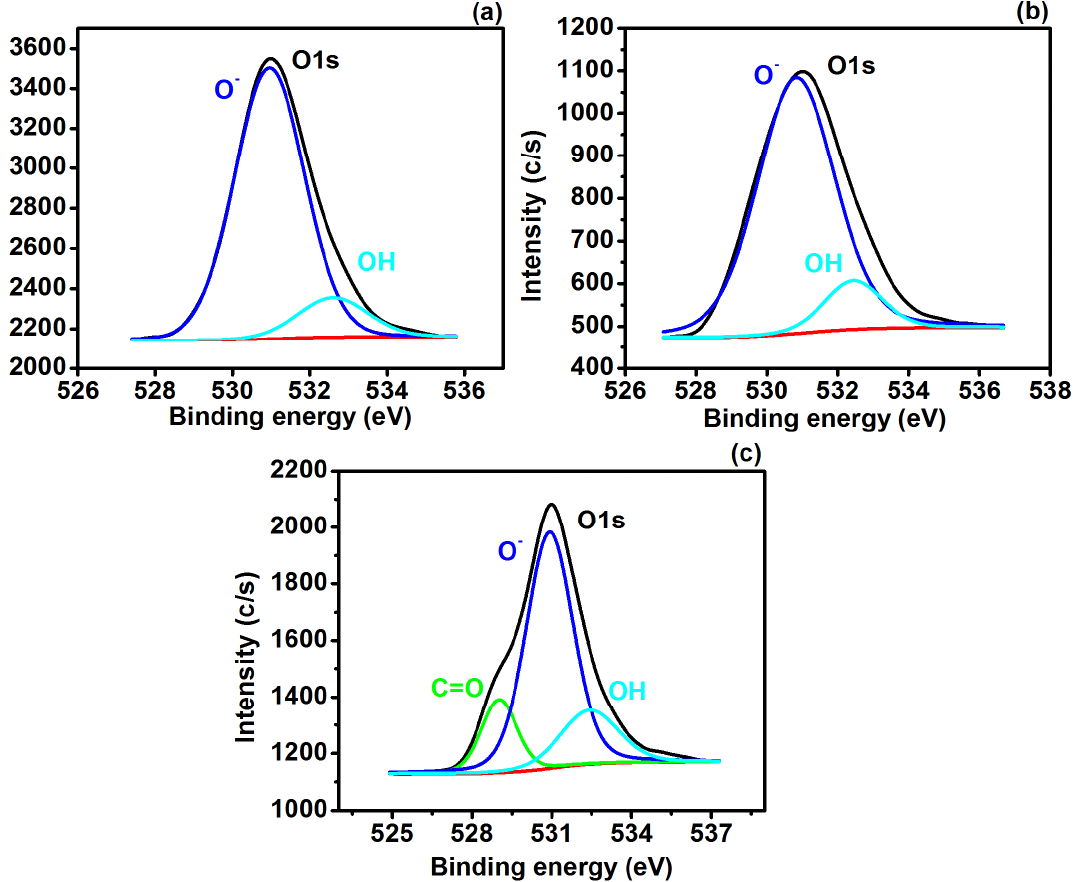
Figure 5. High-resolution O1s analysis for ( a ) MoS 2 , ( b ) MoS 2 -Cu/CuO and ( c ) MoS 2 -Cu/CuO@GN.